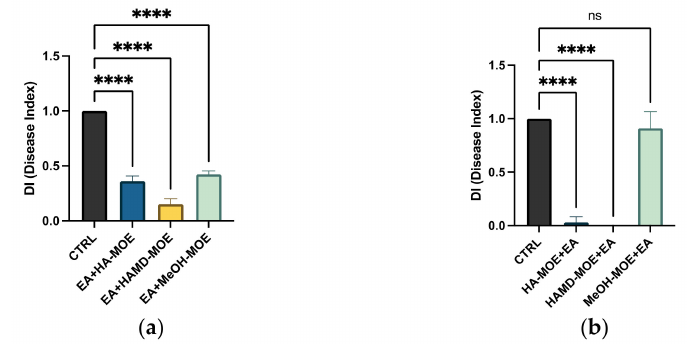
Figure 7. Effects of MOEs in infected apple shoots: ( a ) treatment after infection (therapeutic) and ( b ) treatment before infection (preventive). The EA infection in apple trees was measured by Im- ageJ quantification of the symptomatic area in the shoots and presented as the percentage com- pared to the control. Data are the mean of 3 measurements performed on three different shoots (mean +/ − standard deviation), and values are represented as a percentage; **** p -values <